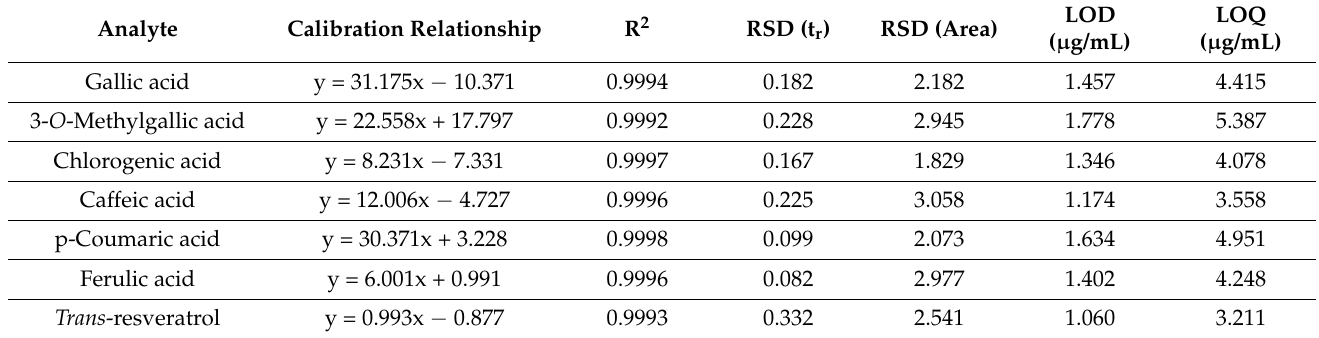
Table 1. Calibration curves, LOD and LOQ for the determination of phenolic compounds by HPLC-DAD.